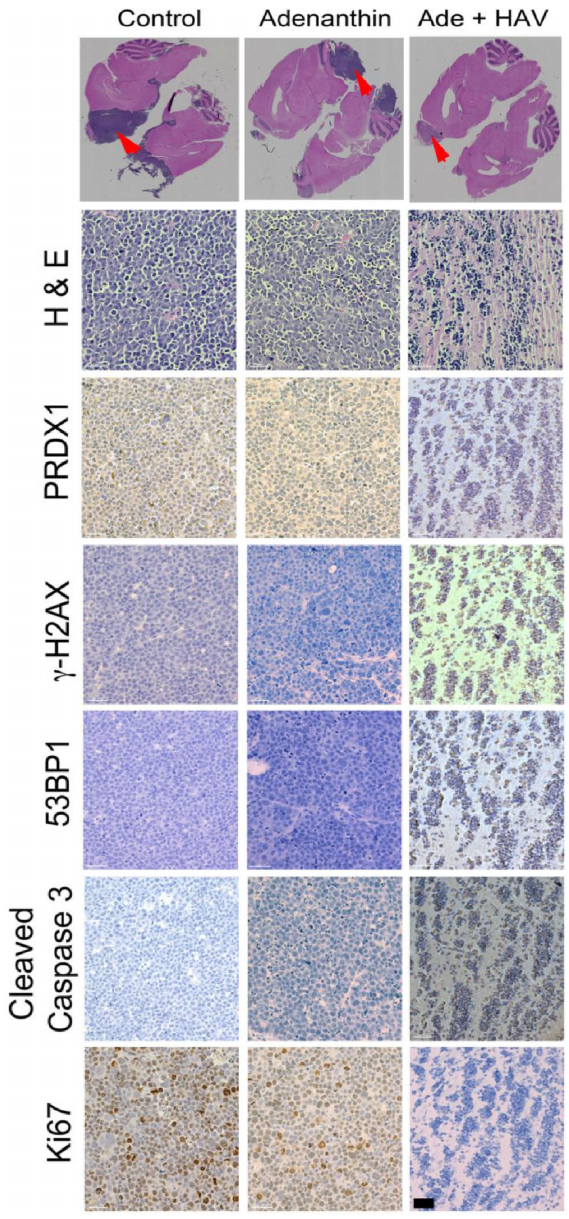
Figure 6. Magnification scans of whole brain sections stained with Hematoxylin and Eosin (H&E) of representative animals that received placebo (control), Ade or a combination of Ade and HAV peptide (Top panel). Arrows indicate those regions that were further examined for various tumor markers (Bottom Panel). White line indicates a scale bar of 100 µ